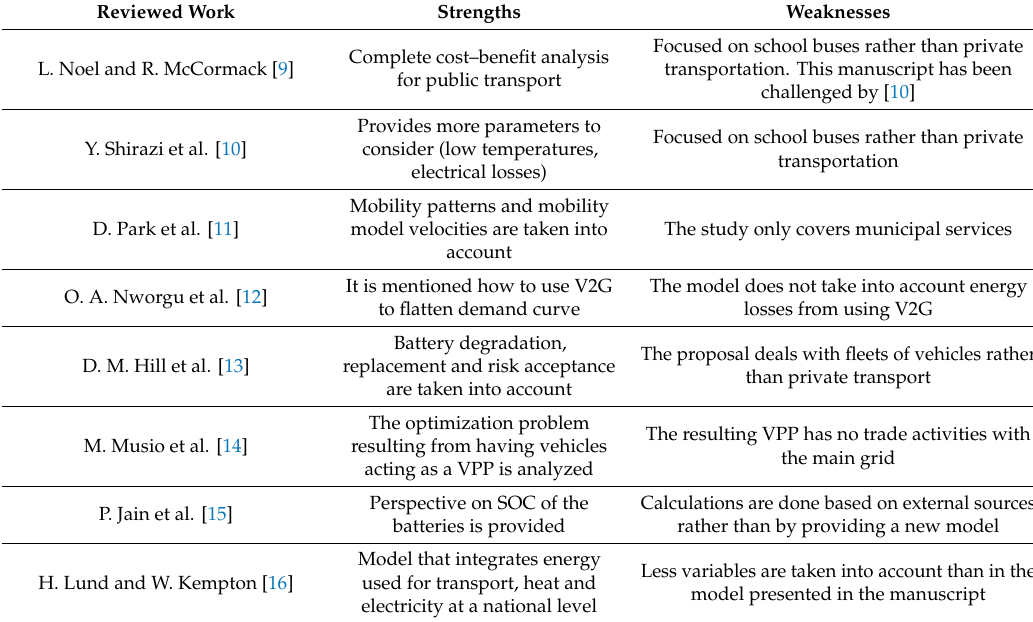
Table 1. Summarization of the main advantages and disadvantages of the reviewed